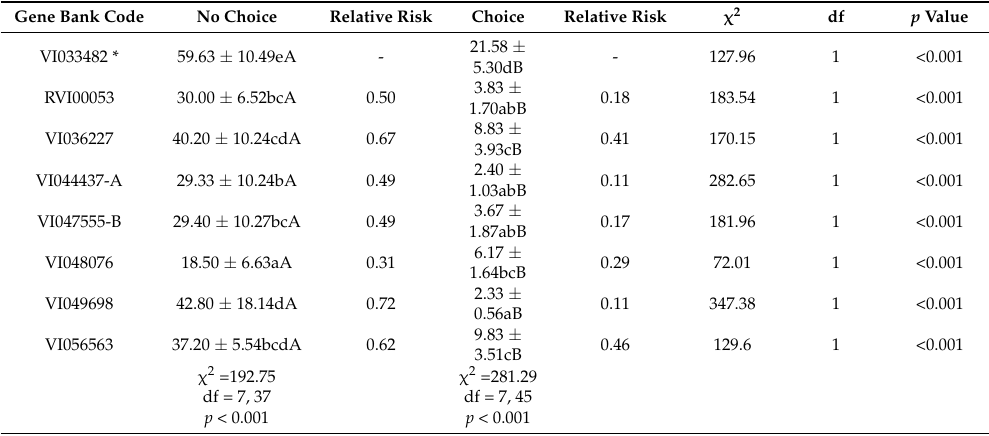
Table 3. Number of eggs (mean ± SE) laid on selected accessions in the no-choice and choice assays. Gene Bank